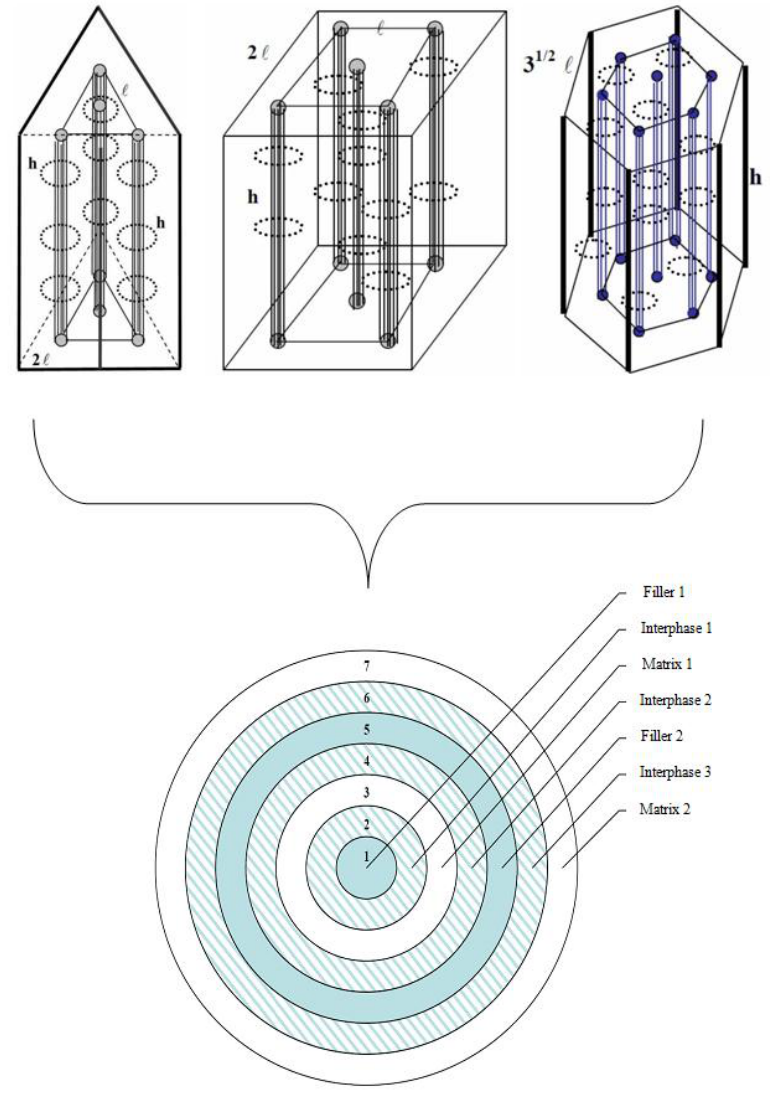
Figure 8. Transformation of the three unit cells into a seven-phase cylindrical model, after the consideration of the interphase concept.